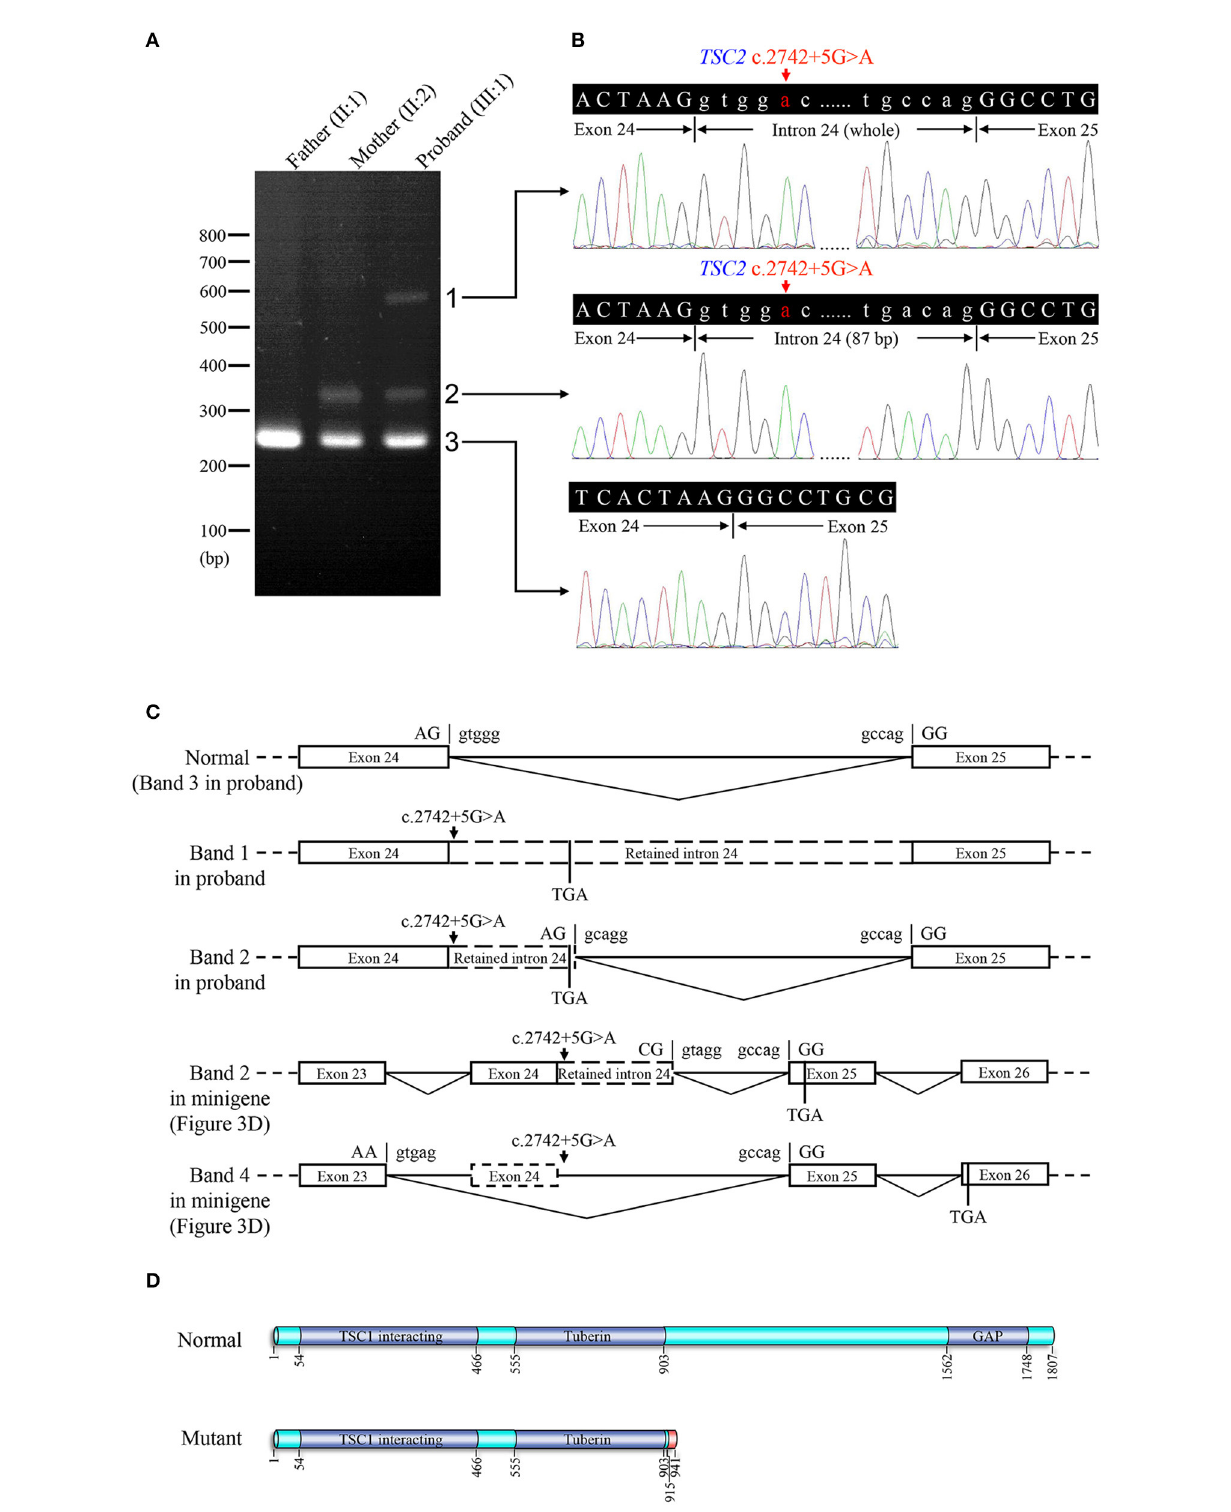
FIGURE4 Reverse transcription PCR and sequencing results of mRNA extracted from family members in the TSC-afflicted family. (A) The electrophoretic figure of the amplification products of TSC2 cDNA from unaffected and affected family members. (B) Sequencing chromatogram of the amplification products of TSC2 cDNA. (C) A schematic diagram of the normal and mutant splicing modes of the TSC2 gene. Splice site sequences and a termination codon (TGA) are shown, in which exonic sequences are in upper case, and intronic sequences are in lower case. (D) Normal and mutant tuberin proteins translated from mRNA sequences detected in patients. Functional domains are in dark blue, and the incorrect amino acid sequence is in